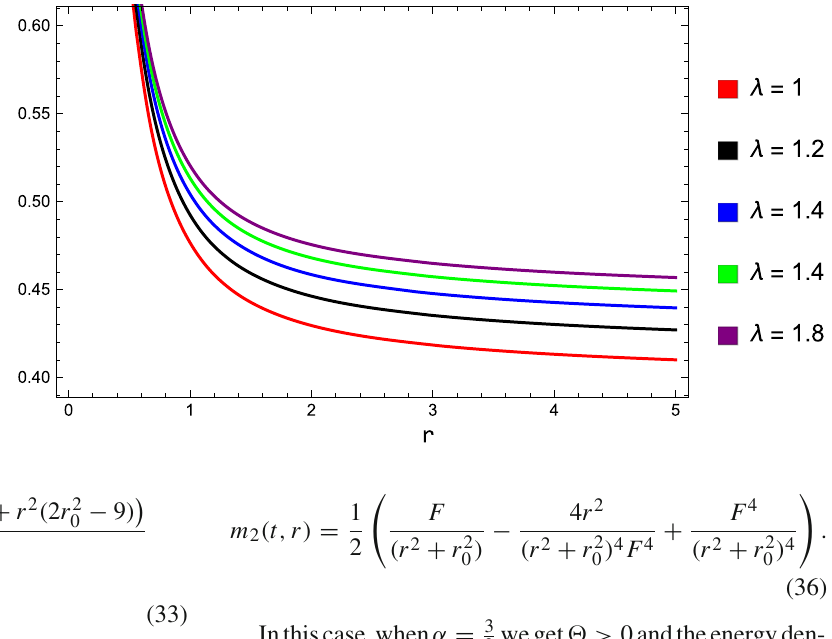
Fig. 4 The variation of (cid:6) a with respect to r for the various values of λ and h 1 ( t ) =